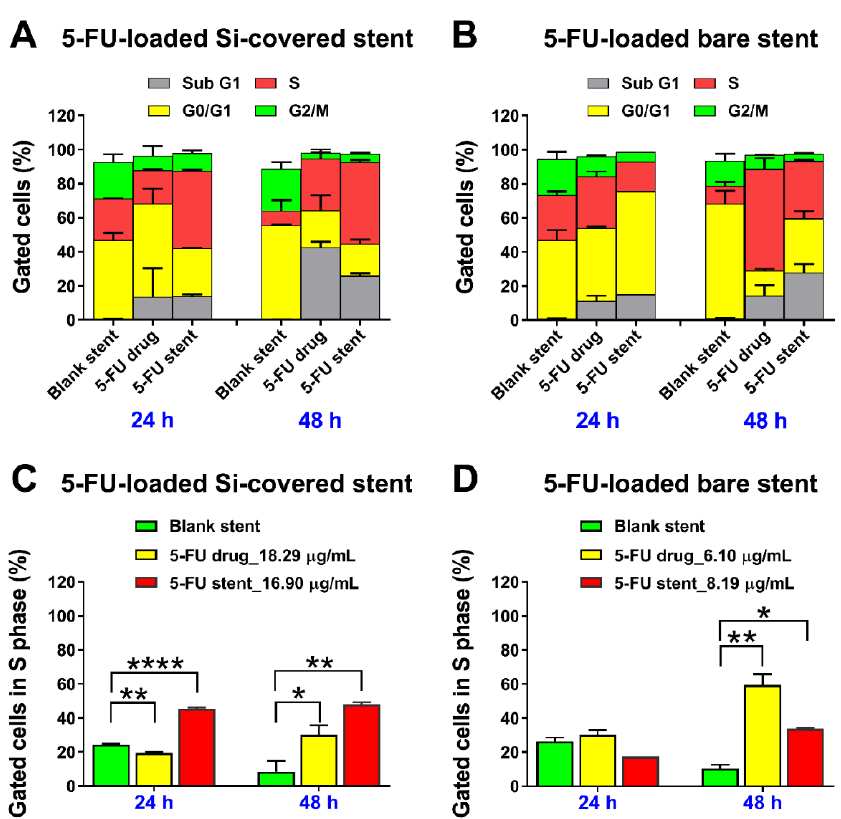
Figure 10. In vitro effects of 5FU released over two days from the ( A , C ) Si-PU 5FU -PEVA and ( B , D ) B-PU 5FU -PEVA stent sections, on ( A , B ) different phases or in the ( C , D ) S phase of HCT-116 human colon cancer cells treated for 24 and 48 h; evaluated using flow cytometry. Cell cycle data are presented without subtracting the value of untreated control (media), as mean ± SD from two independent experiments. **** p < 0.0001, ** p < 0.01 and * p < 0.05 compared to blank (drug-free) bilayer coated nitinol control